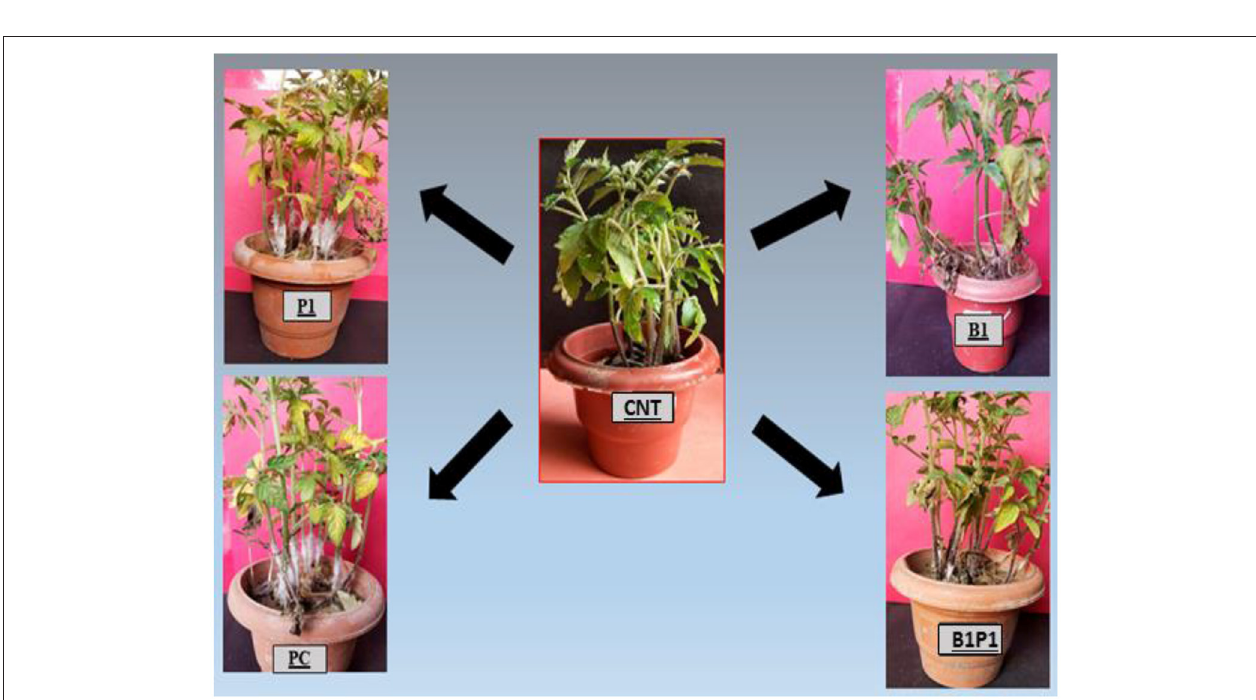
than July to November. The size of the pentagons, i.e., the